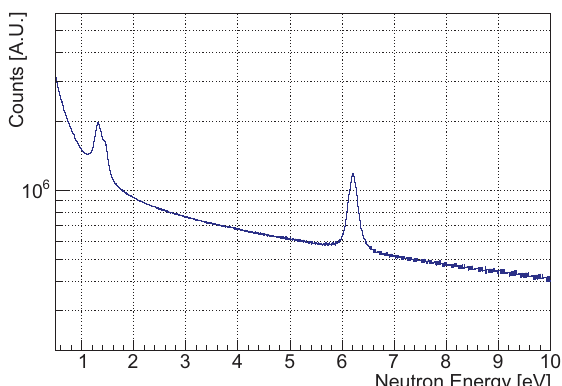
Figure 2. The energy spectrum of neutrons absorbed by the target. The peak on the left includes the p-wave resonance at 1.33